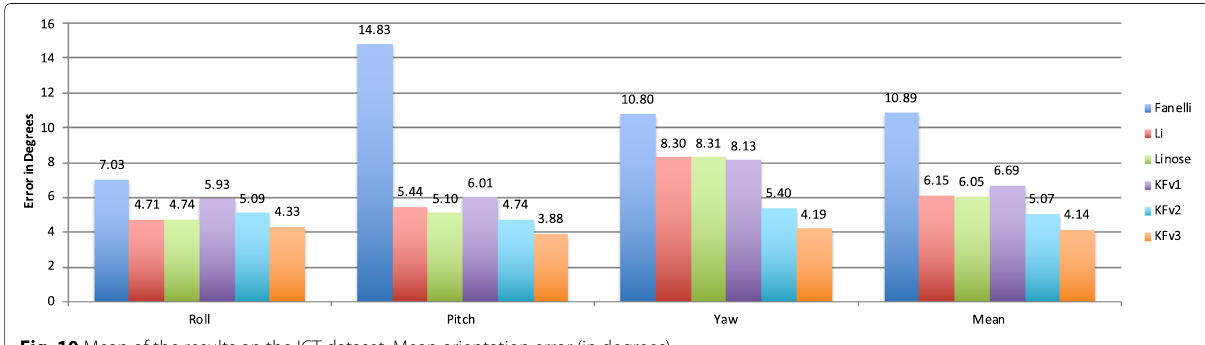
Fig. 10 Mean of the results on the ICT dataset. Mean orientation error (in degrees)